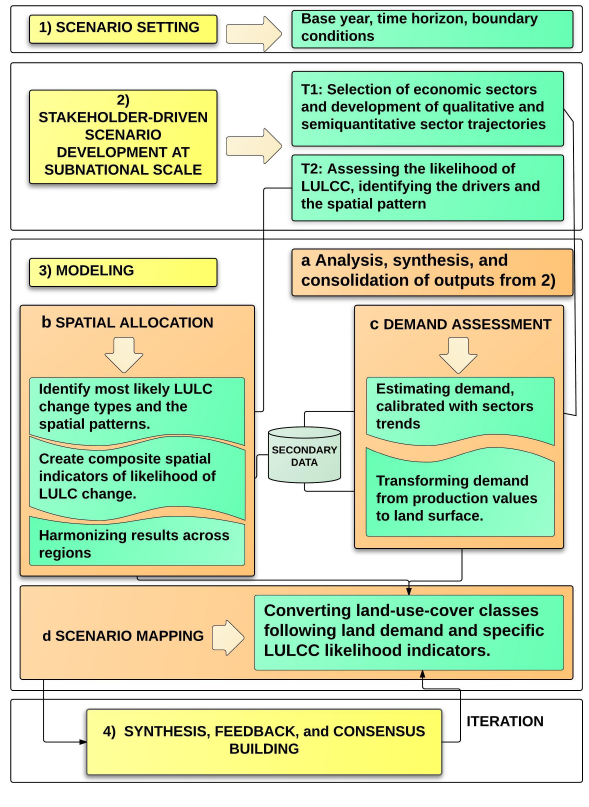
Fig. 1 . Conceptual model of the scenario framework